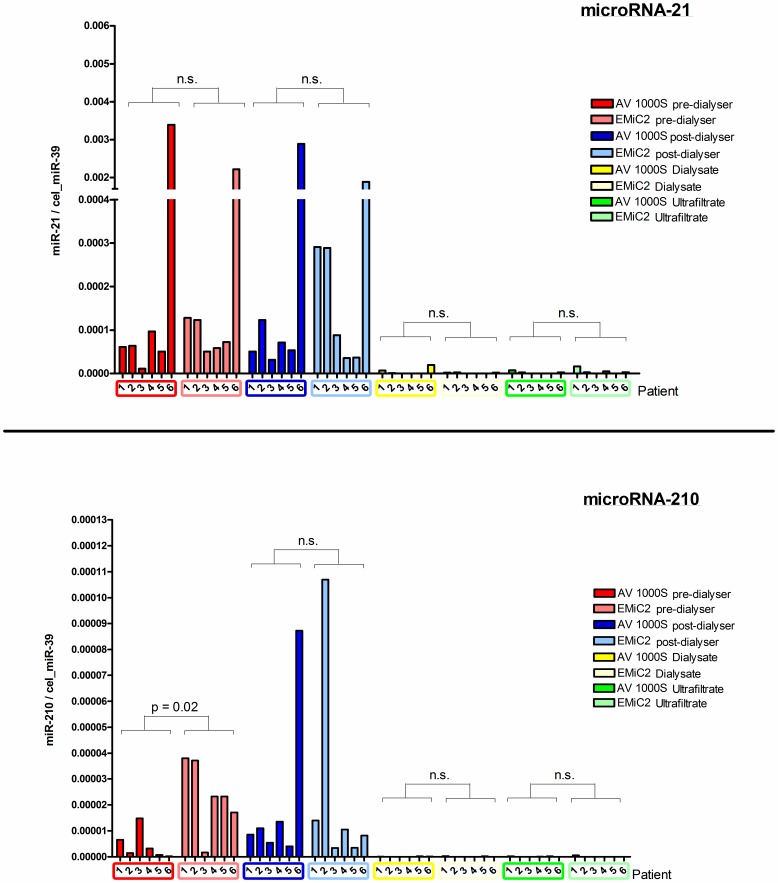
Comparison of influence of two different filter properties on circulating microRNA levels.Six patients received at least one dialysis session with each of the two filter systems AV 1000 S and EMiC 2. Circulating levels of miR-21 and -210 were not differently altered by the two different dialyser properties. (miR-21: AV1000S pre-dialyser vs. EMiC 2 predialyser p = 0.59, post-dialyser p = 0.70, dialysate p = 0.94, ultrafiltrate p = 0.39; miR-210: pre-dialyser p = 0.02, post-dialyser p = 0.82, dialysate p = 0.59, ultrafiltrate p = 0.31) Only pre-dialyser line showed a significant alteration, which is not of relevance for our main conclusion. Data are represented as mean and standard error of the mean.